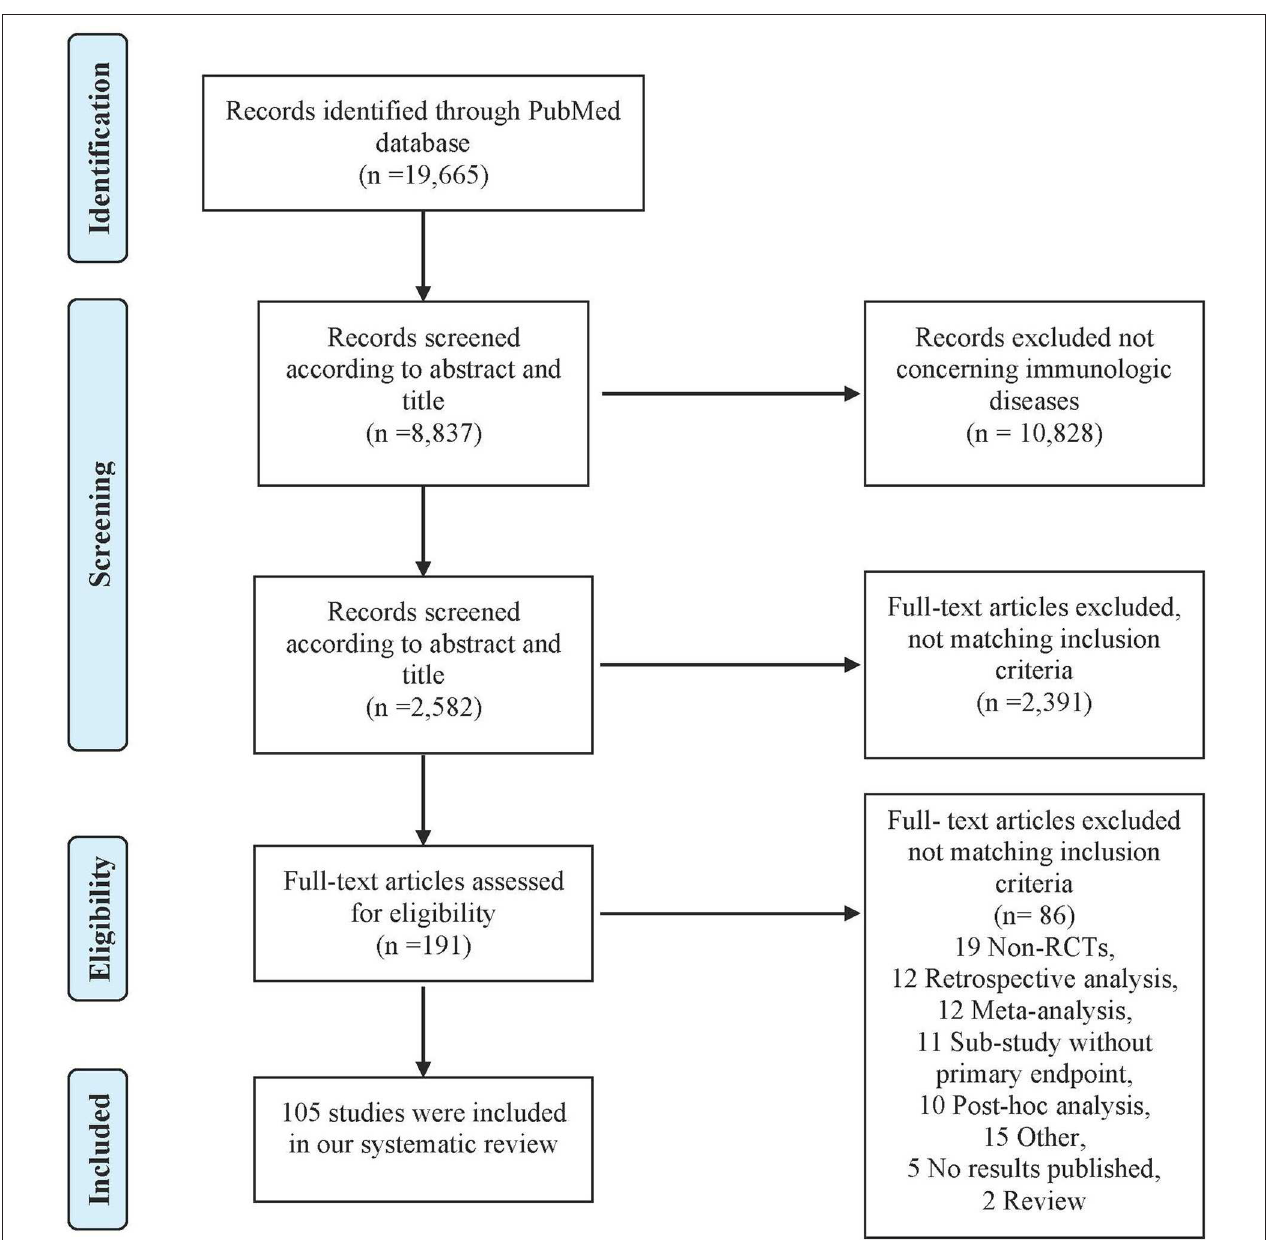
FIGURE 1 | PRISMA diagram of the literature